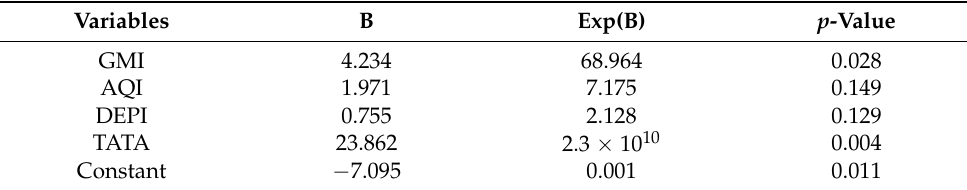
Table 4. Multivariate logistic regression.